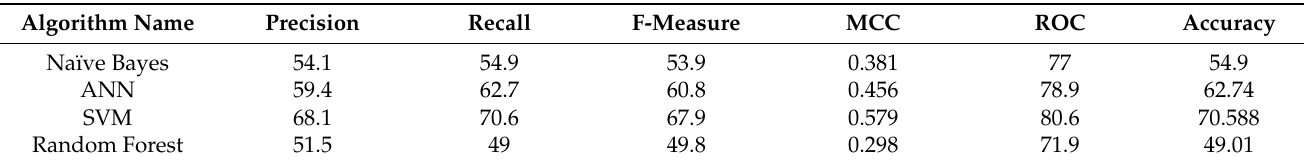
Table 7. Comparison among classification algorithms using 10-fold cross-validation testing to predict the total infected cases.